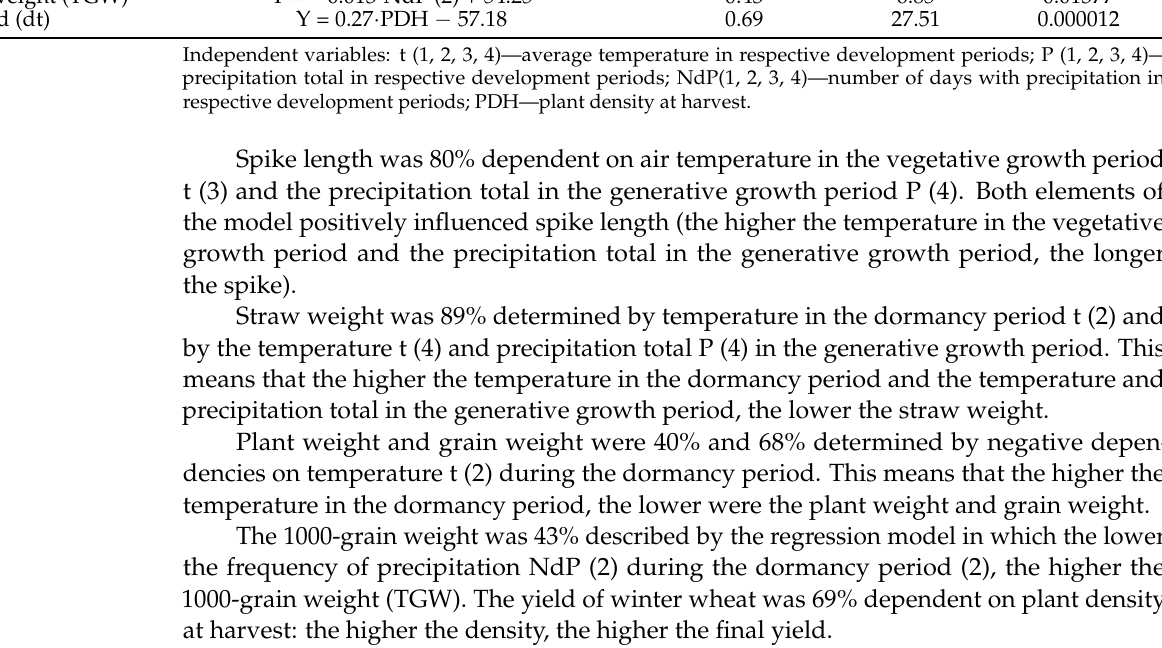
Determination Coefficient R